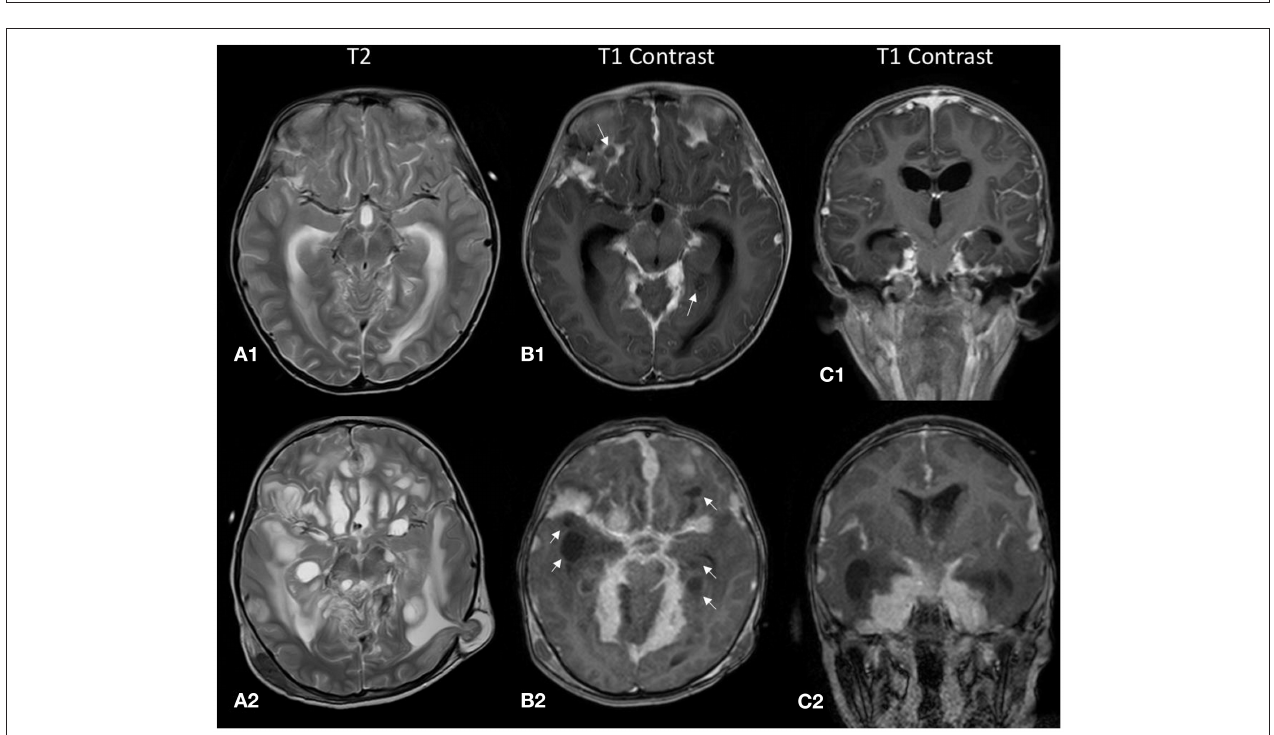
FIGURE 1 | The top row (A1–G1) displays magnetic resonance (MR) images from the initial study during the first admission, and the bottom row (A2–G2) displays the corresponding images during the relapse 2 months later. The lesion (A1,A2) returns an isointense signal on T1-weighted images and (B1,B2) demonstrates enhancement on post-contrast images. (C2) High T2-signal cystic lesions are seen along the leptomeningeal surface that increased in size and number during the relapse. (D2) The internal signal of these cystic lesions is not entirely suppressed on fluid attenuation inversion recovery (FLAIR) sequence. (E1,E2) No blooming artifacts seen on gradient echo (GRE) sequence. (F1,G1;F2,G2) Restricted diffusion is not demonstrated in both